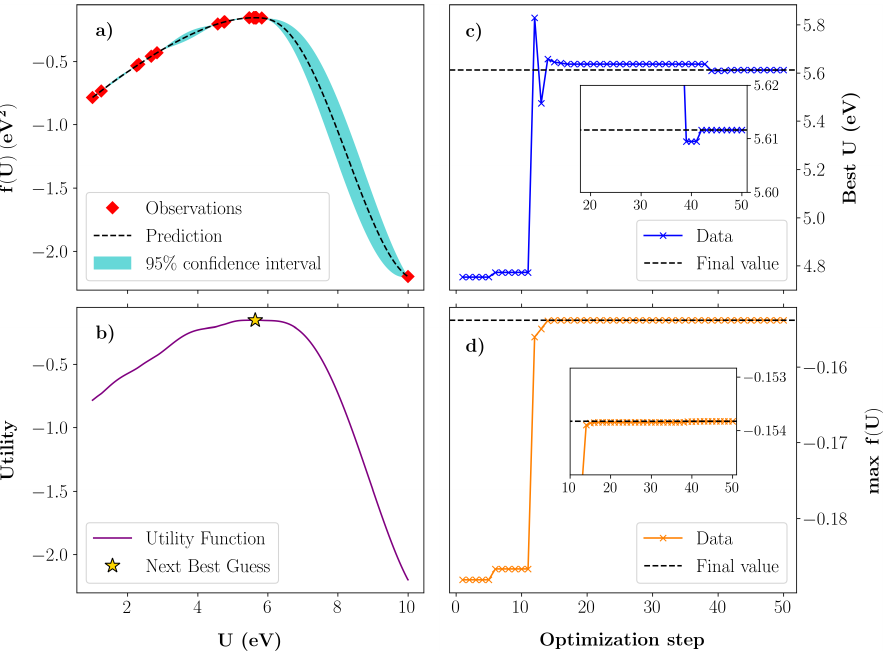
Figure 1. Performance of Bayesian optimization of Hubbard U in GaN: ( a ) approximate objective function, observations, and 95% confidence interval after 50 optimization steps; ( b ) Utility (acqui- sition) function after 50 steps, with the next point to be evaluated as suggested by the algorithm; ( c ) Evolution of the predicted best value of U, the inset shows the Us within ± 0.01 eV about the final value; ( d ) Best approximation of the maximum of the objective function as a function of the optimization step, the inset shows maxima of f within ± 0.001 window around the final value.